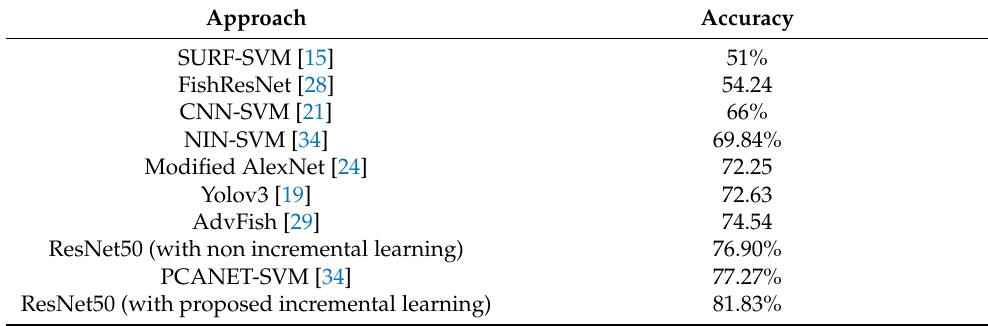
Table 3. Comparison of fish recognition accuracies of various methods on the LCF-2015 dataset.